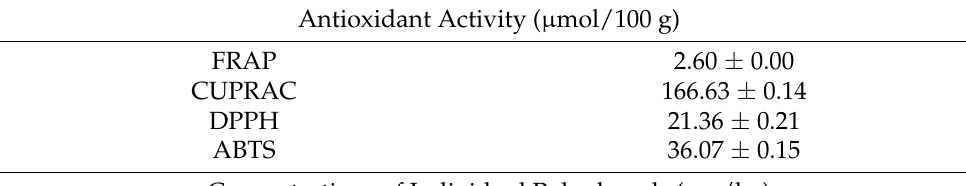
Table 1. Evaluation of chokeberry juice polyphenols and antioxidant